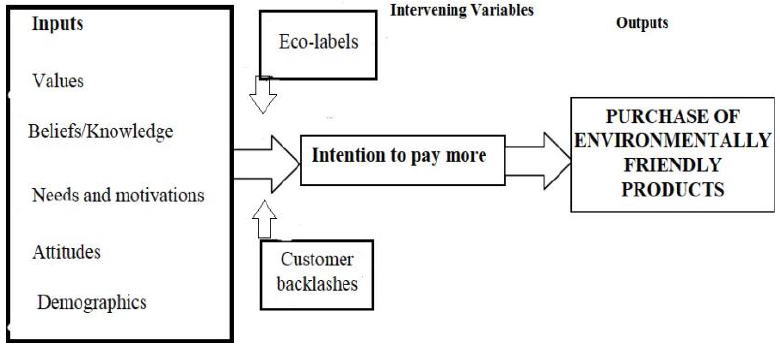
Figure 2: Variables that drive consumer choice to purchase green products; Source: Bui